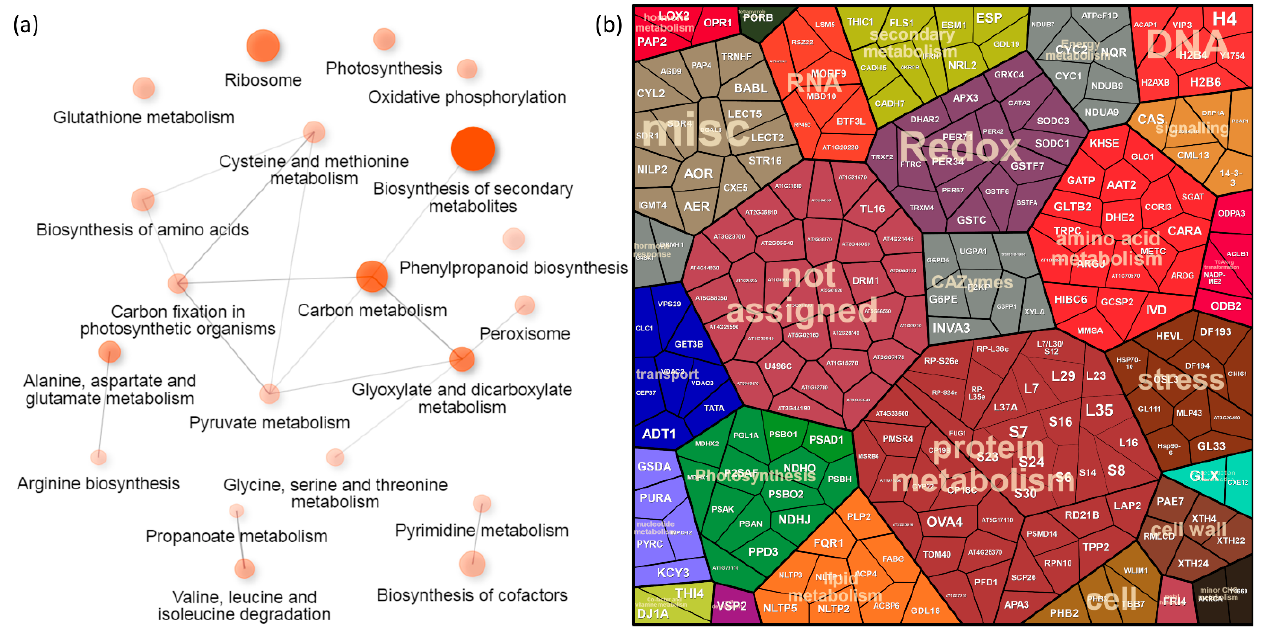
Figure 6. Diurnal variation in lhy mutant. ( a ) The most significant metabolic pathways found in diurnally regulated proteins and ( b ) visualization of all the differentially abundant proteins ( p < 0.05, at least a 1.5-fold change) in the ProteoMap. For details, see Supplementary Table S1.